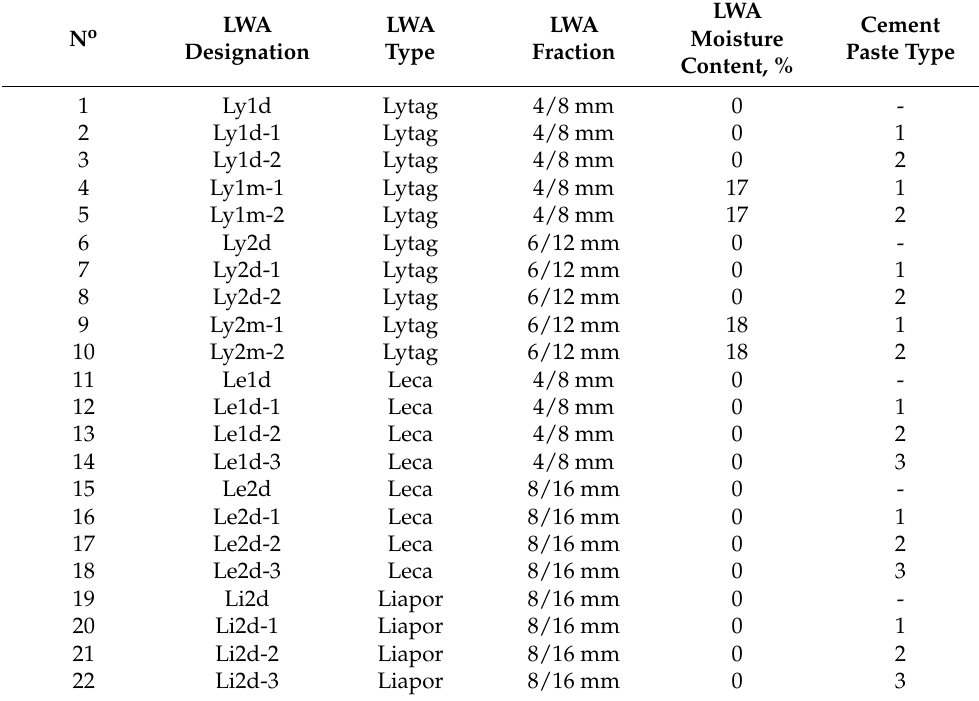
Table 4. Description of impregnated and non-impregnated LWAs used in the research.